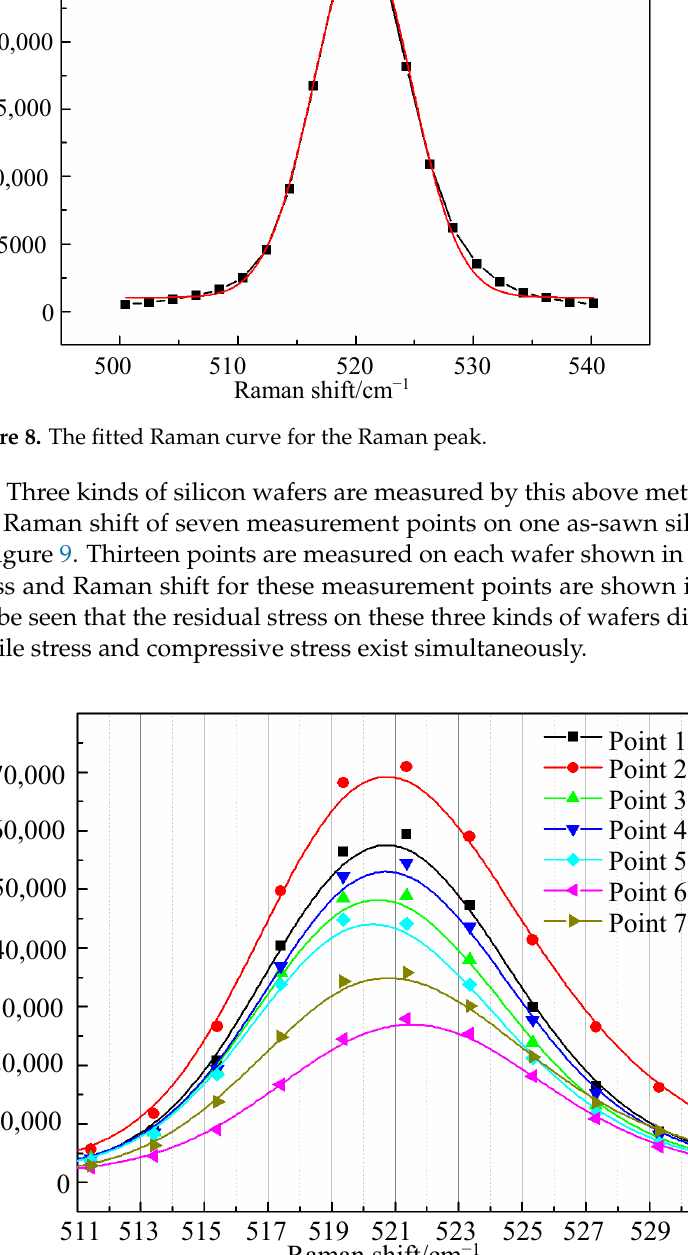
Figure 9. Seven fitted Raman peak curves for one kind of wafer.